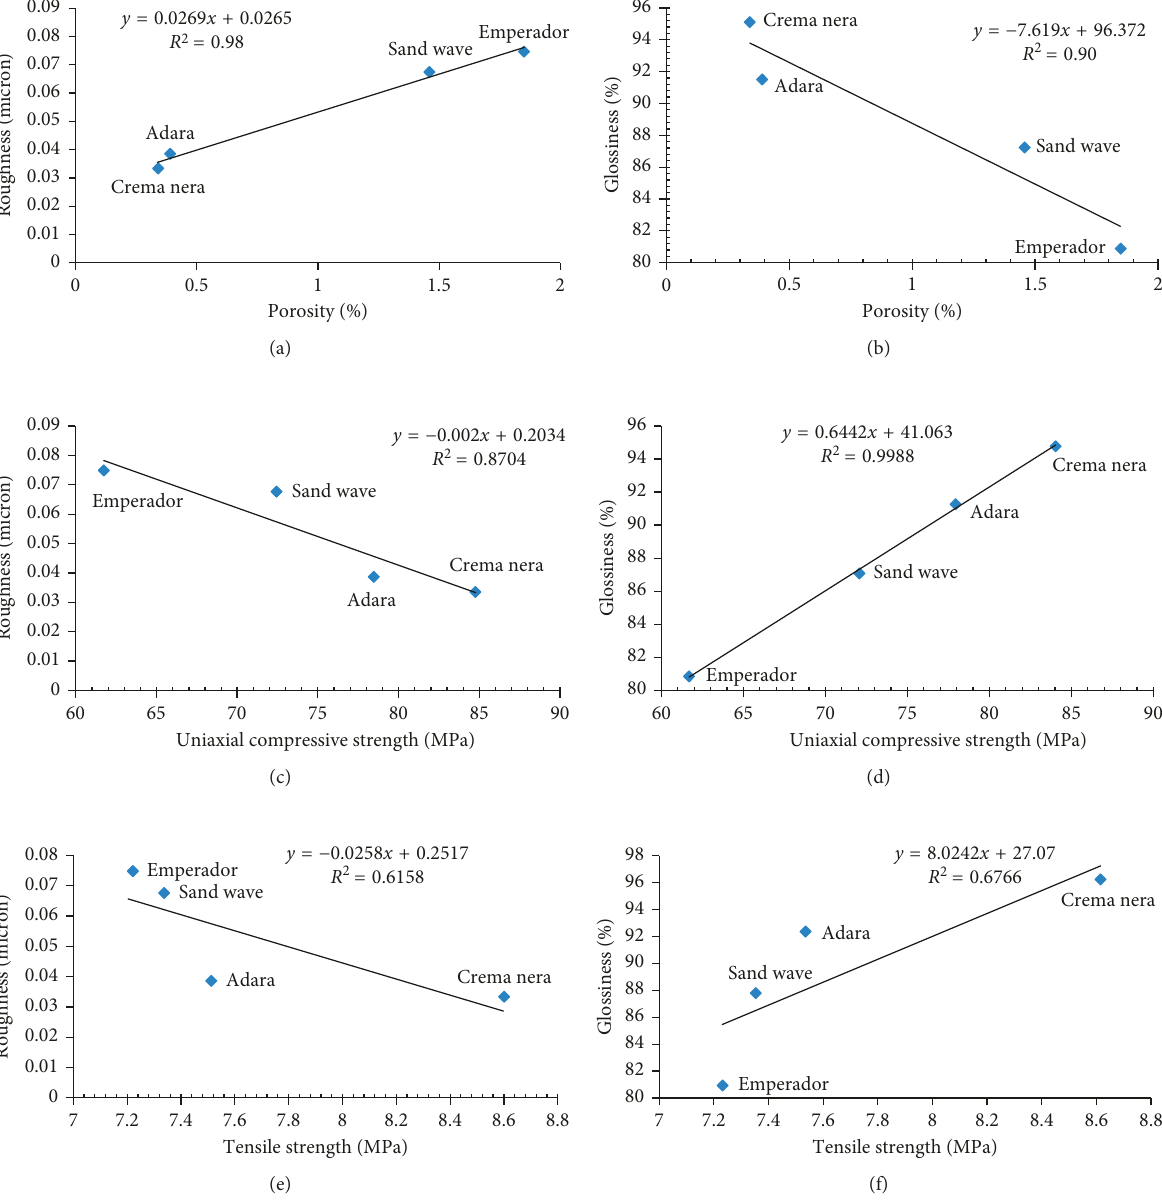
Figure 5: Physicomechanical properties versus roughness and glossiness. (a) Porosity versus roughness. (b) Porosity versus glossiness. (c) Uniaxial compressive strenght versus roughness. (d) Uniaxial compressive strenght versus glossiness. (e) Tensile strenght versus roughness. (f) Tensile strenght versus